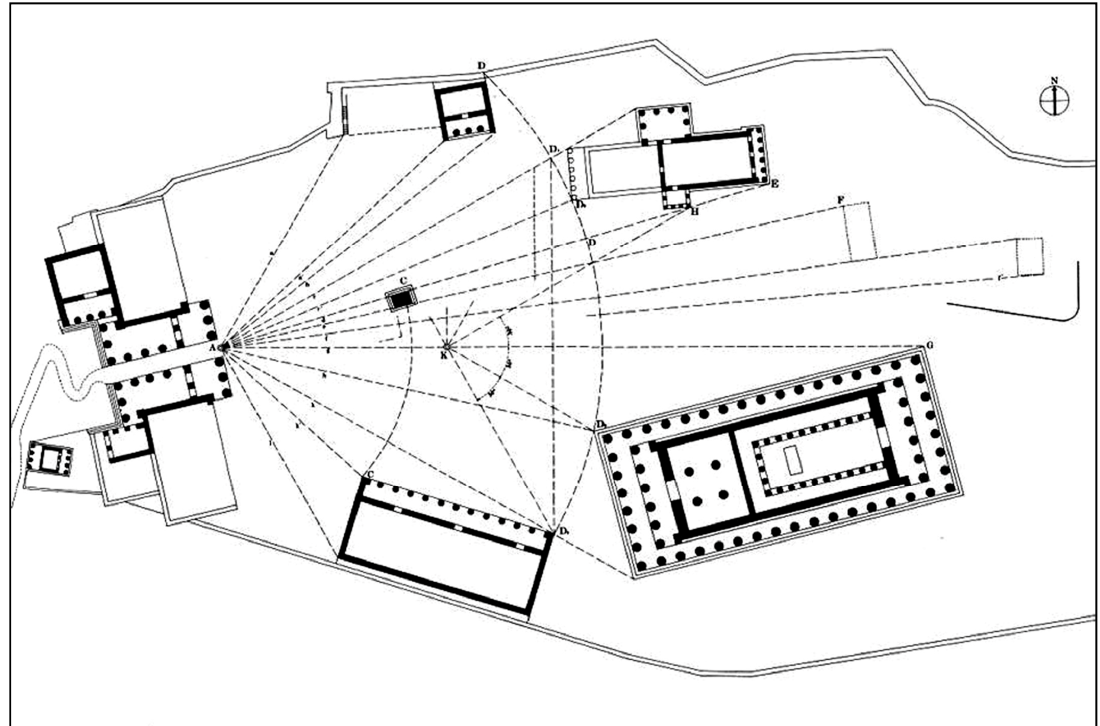
Figure 1. The central eye in the Greek space according Constantinos